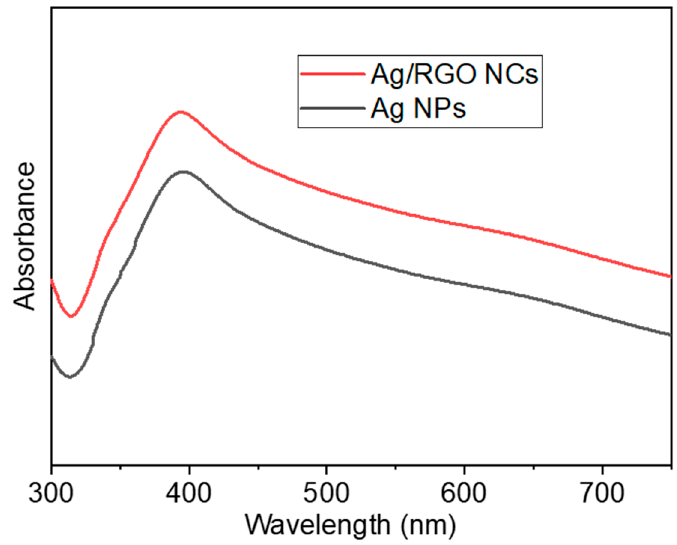
Figure 2. UV-visible spectra of Ag NPs and Ag/RGO NCs prepared from orange peel extract.